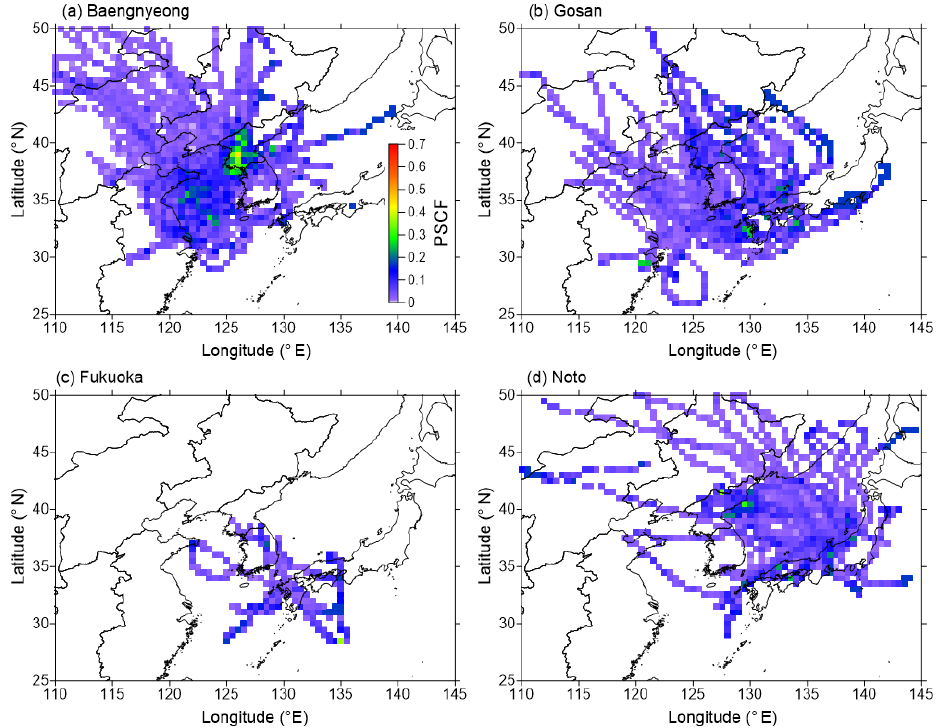
Figure 6. Same as Fig. 5, except for the mean fractional bias (MFB) ≤ − 0 . 5 for underestimation